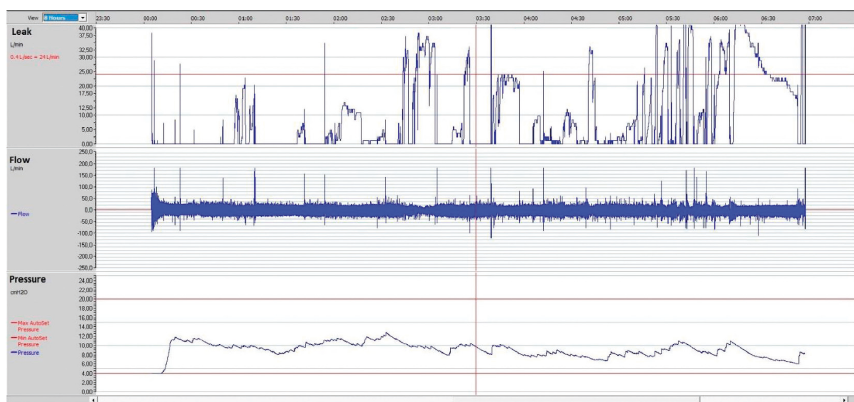
Figure 7: Notice the sawtooth shape of the leak curve in the upper right side. This indicates an abnormal and intermittent leak with a normalization of the leak between leak episodes. The sawtooth shape is usually caused by a mouth leak, as mouth leaks are never continuous. Such leaks dry the mouth and force the patient to close their mouth to restore mouth